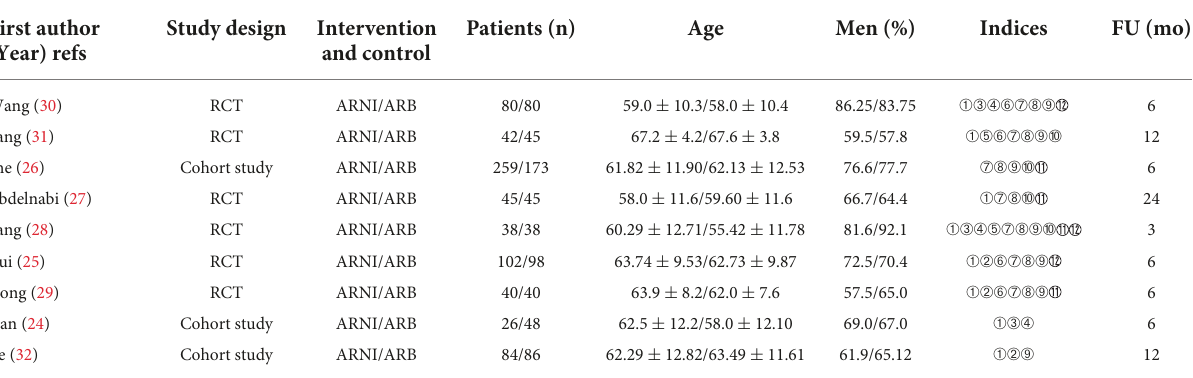
TABLE 1 Characteristics of the clinical trials included in the